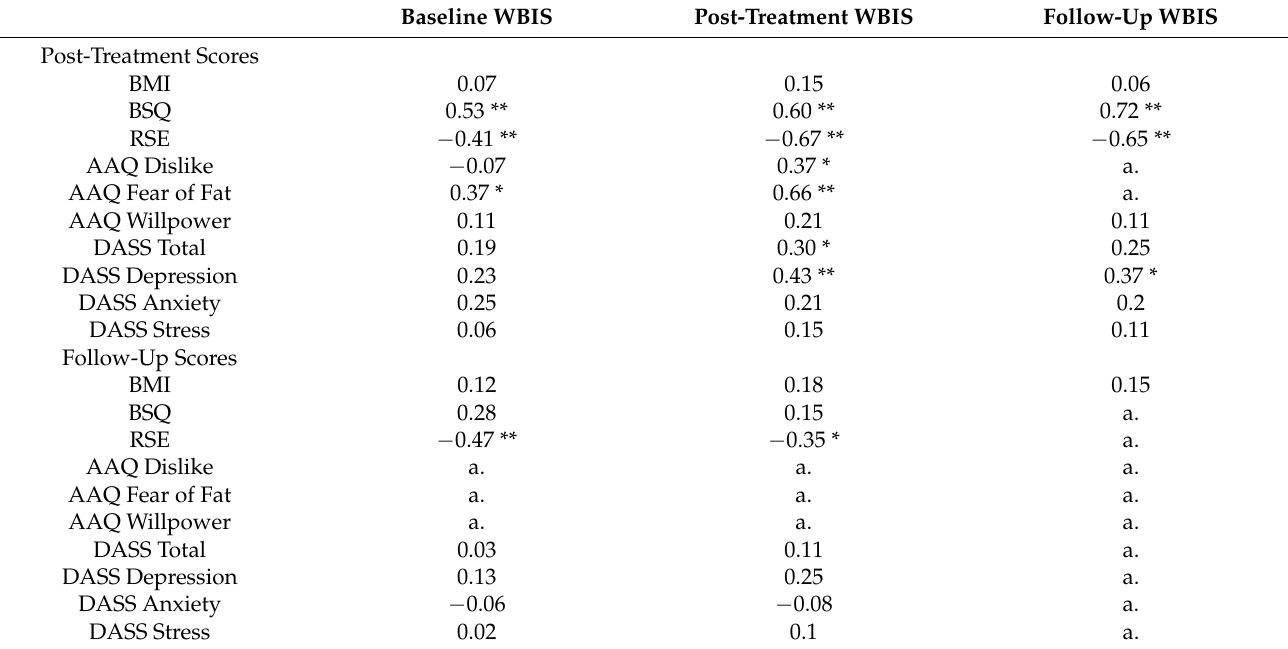
Table A1. Pearson product-moment correlations among internalized weight bias scores at post- treatment and follow-up and psychological